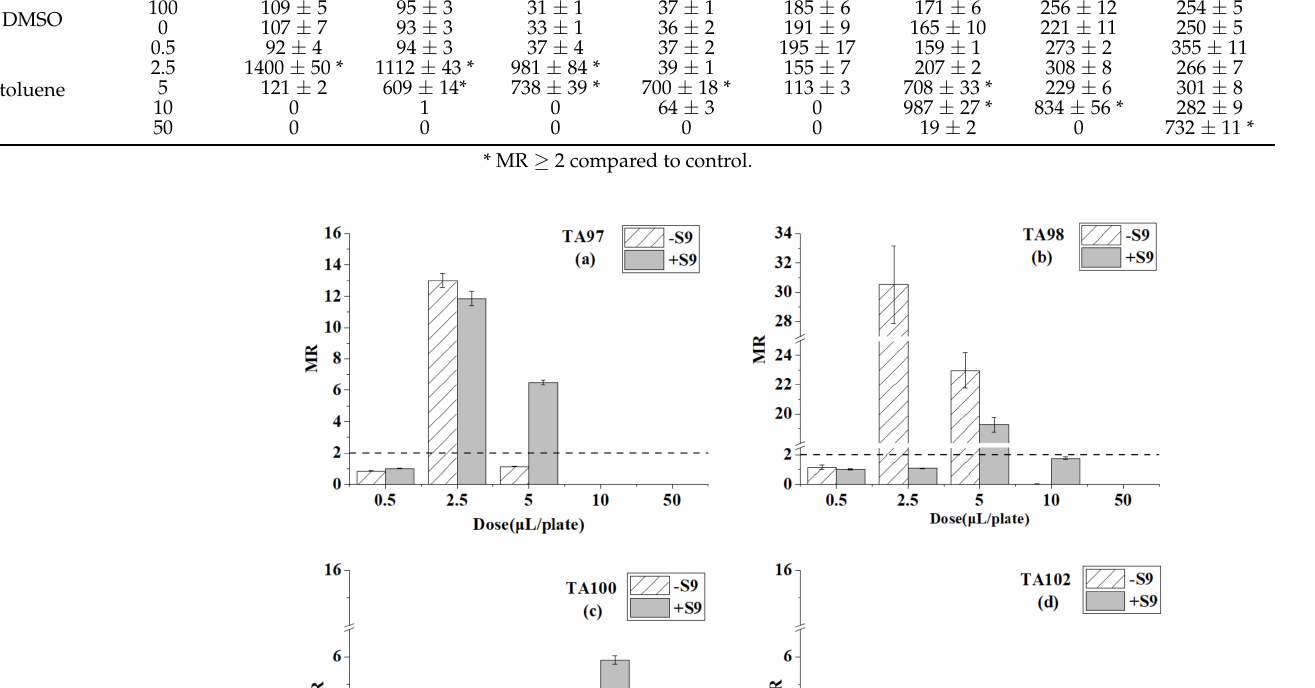
Table 1. Reverse mutation colonies of four S. typhimurium strains exposed to toluene with and without S9. Chemicals